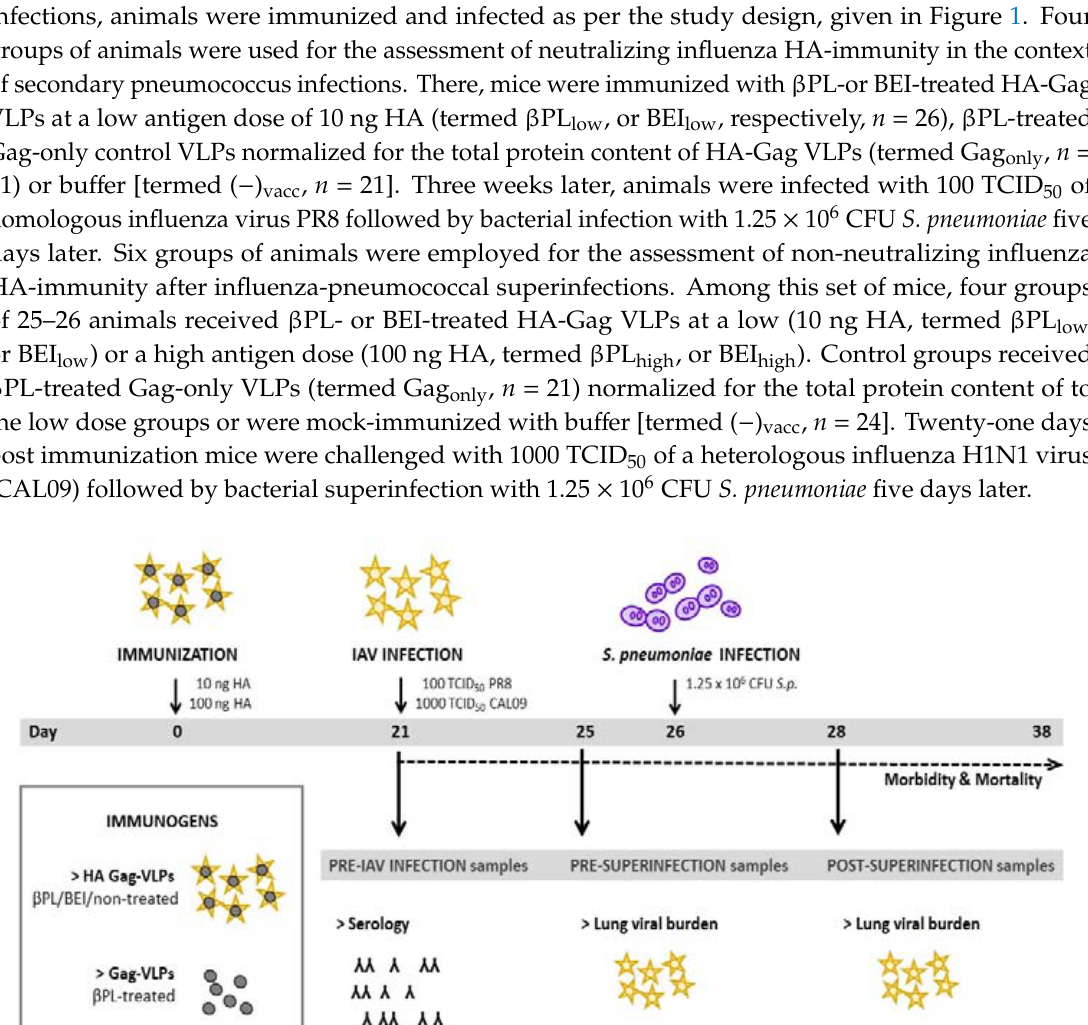
Figure 1. Study design. BALB / c mice were immunized by intraperitoneal injection (IP) with either a β PL / BEI- or non-treated preparation of insect cell-expressed influenza hemagglutinin (HA)-Gag virus-like particles (VLPs), β PL-treated Gag-VLPs or were mock-vaccinated with HEPES bu ff er. The HA was from PR8. Twenty-one days after immunization, mice were either challenged with 100 TCID 50 of homologous PR8 or 1000 TCID 50 of homosubtypic heterologous CAL09 (NIBRG-121xp) and received a secondary infection with 1.25 × 10 6 CFU of a clinical serotype 4 strain of S. pneumoniae five days later. Immunogenicity of the VLP preparations was assessed in pre-challenge sera three weeks post-immunization. The e ffi cacy of anti-HA immunity in suppressing influenza-mediated innate type I / II interferon (IFN) expression and in limiting exacerbation of disease and mortality (pathogen burden, morbidity, and mortality) was evaluated.